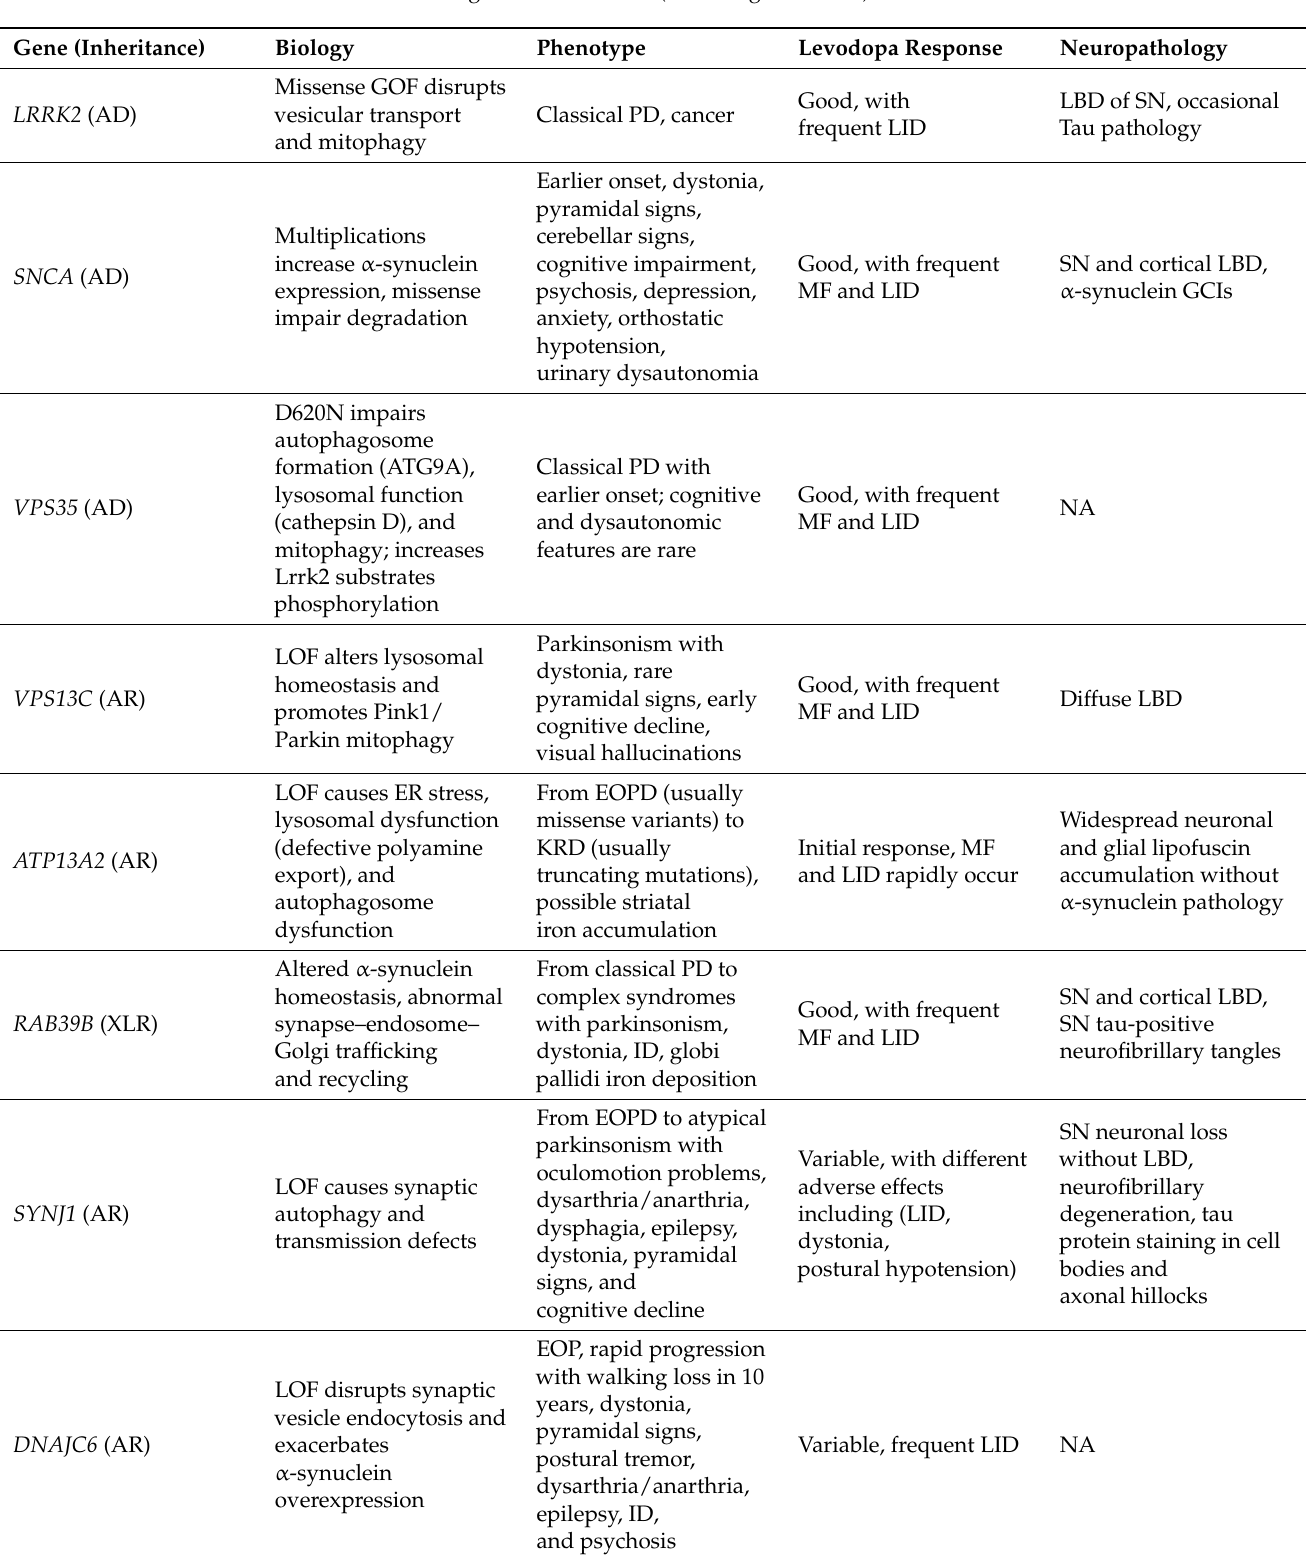
Table 1. Monogenic causes of PD (including GBA1